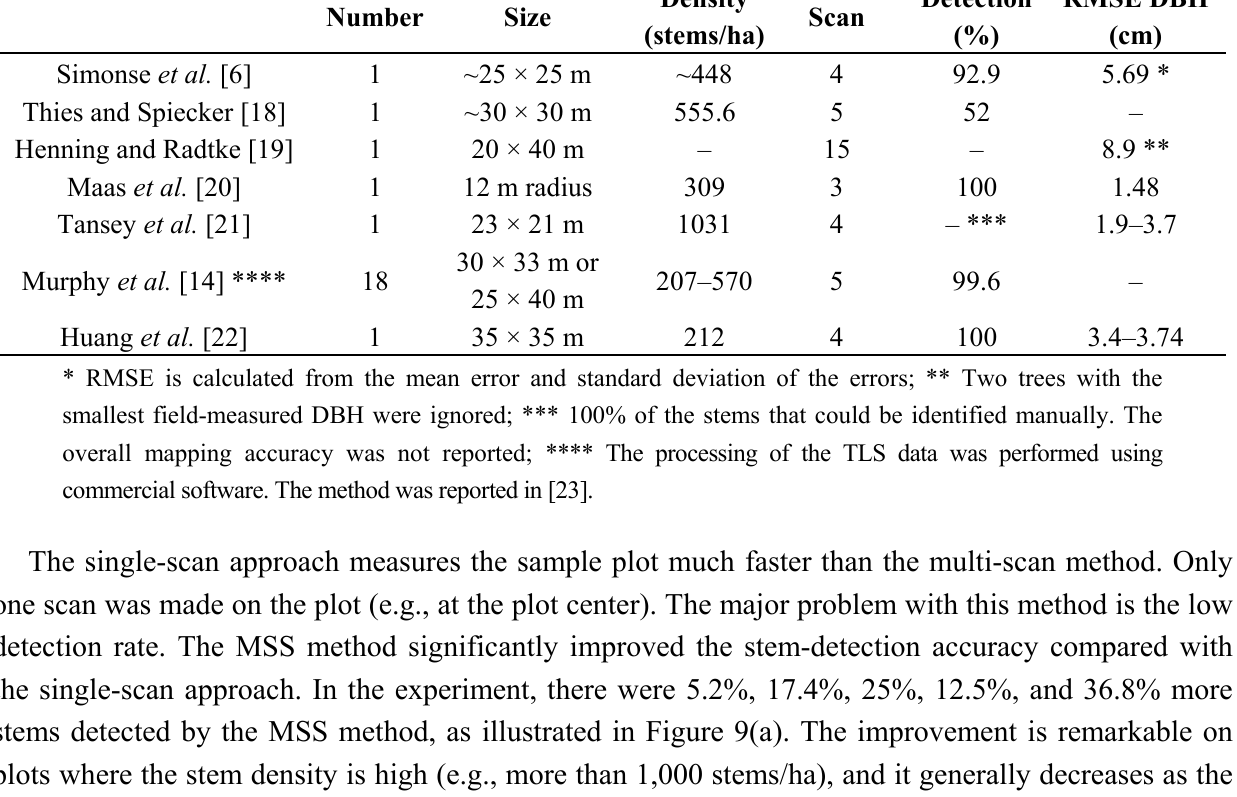
Table 6. Summary of the mapping results of the multi-scan method reported in references. Plot